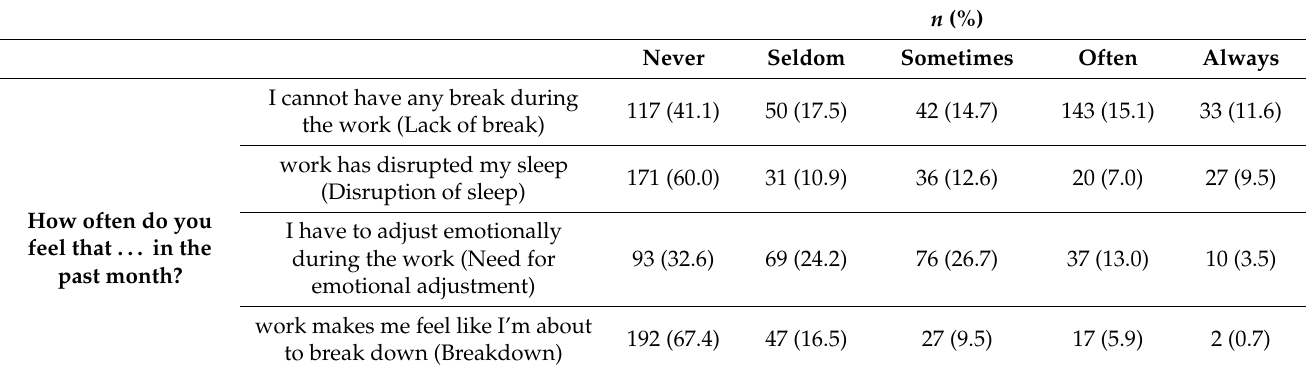
Table 4. Psychometric characteristics related to